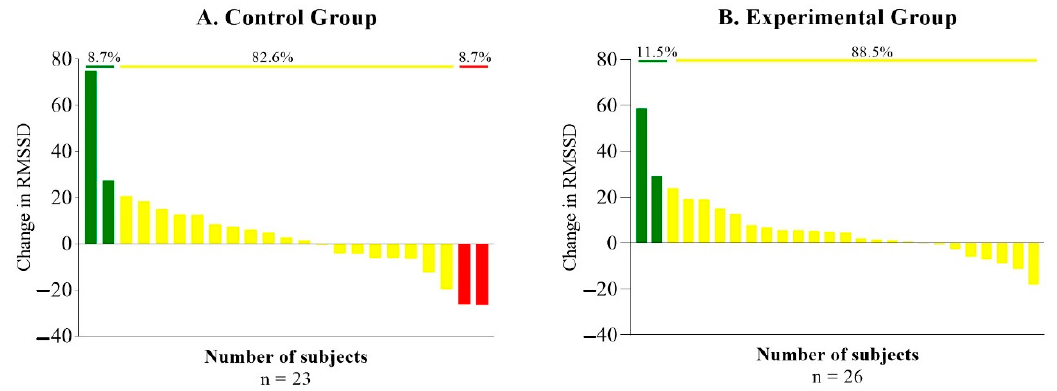
Figure 2. Responders (green line), non-responders (yellow line), and adverse responders (red line) on RMSSD endpoints. RMSSD; root mean square successive difference.